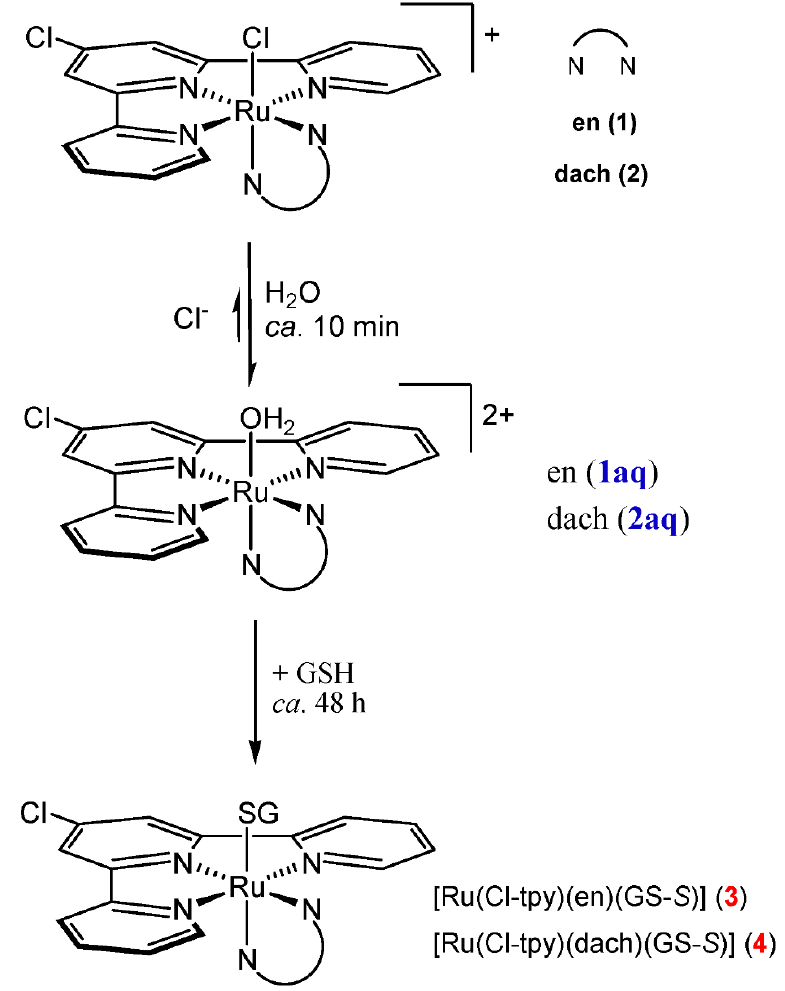
Scheme 1. Reaction pathways of [Ru(Cl-tpy)( N-N )Cl] + with GSH in aqueous